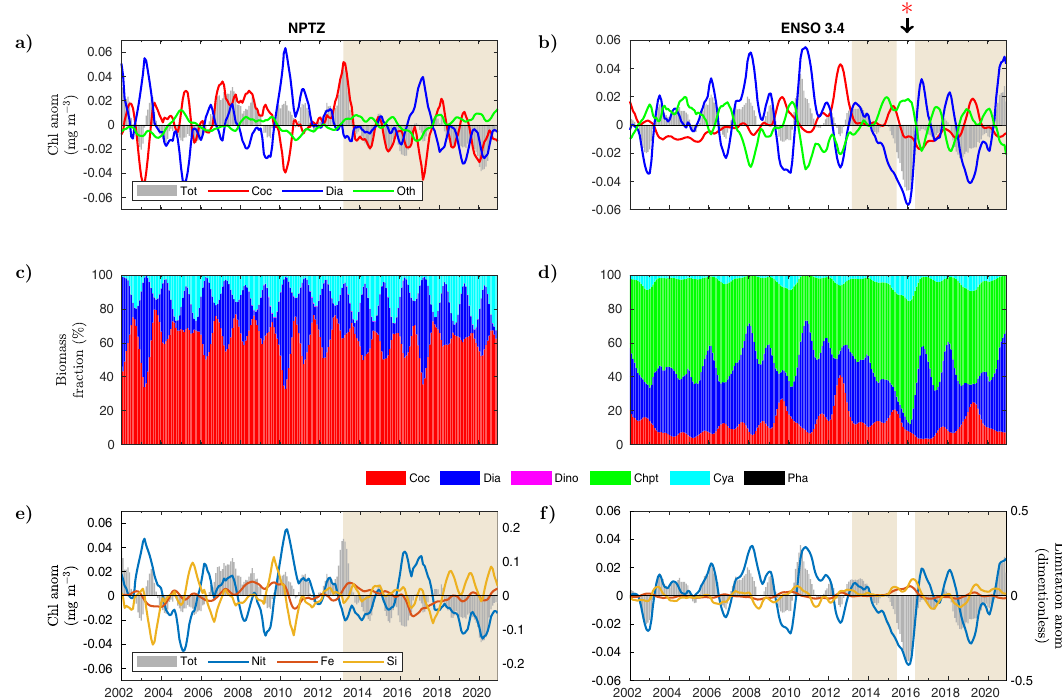
Fig. 3 Monthly anomalies in phytoplankton functional types (PFTs) and nutrient limitation in NPTZ and ENSO 3.4. a , b ( a ) NPTZ and ( b ) ENSO 3.4 modeled anomalies (mg m − 3 ) in total surface chlorophyll (gray bars), coccolithophores (red line), diatoms (blue line), and dino fl agellates, cyanobacteria, chlorophytes, and phaeocystis combined together (summed) (green line). c , d Fraction of modeled total Chl biomass (%) corresponding to each PFT in ( c ) NPTZ and ( d ) ENSO 3.4 (coccolithophores-red, diatoms-blue, dino fl agellates-magenta, chlorophytes-green, cyanobacteria-cyan, and phaeocystis- black). e , f Anomalies in modeled surface chlorophyll (mg m − 3 ) (gray bars) and the growth-limiting term (unitless) of nitrate (blue), iron (red), and silicate (yellow) in ( e ) NPTZ and ( f ) ENSO 3.4. Area of beige background indicates the anomalously warm period starting in March 2013. Red asterisk indicates the period between November of 2015 and March of 2016 when noticeable changes in modeled PFT composition occurred in ENSO 3.4. Monthly anomalies are smoothed using a 6-month rolling